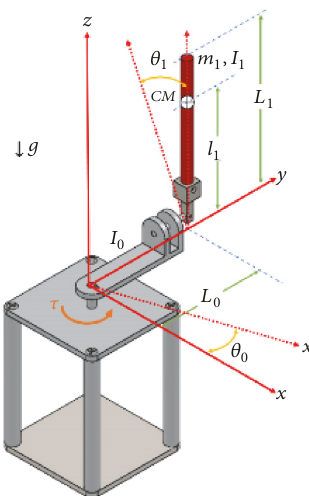
Figure 3: The rotational pendulum.